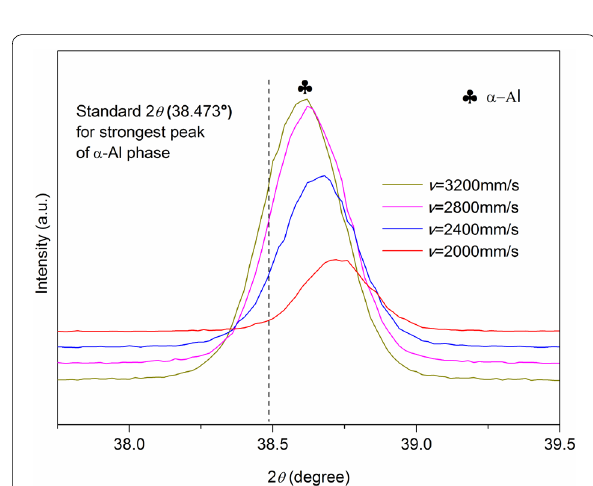
Figure 6 XRD spectra in the vicinity of the strongest diffraction peak at different scan speeds, showing the changes of the α-Al diffraction